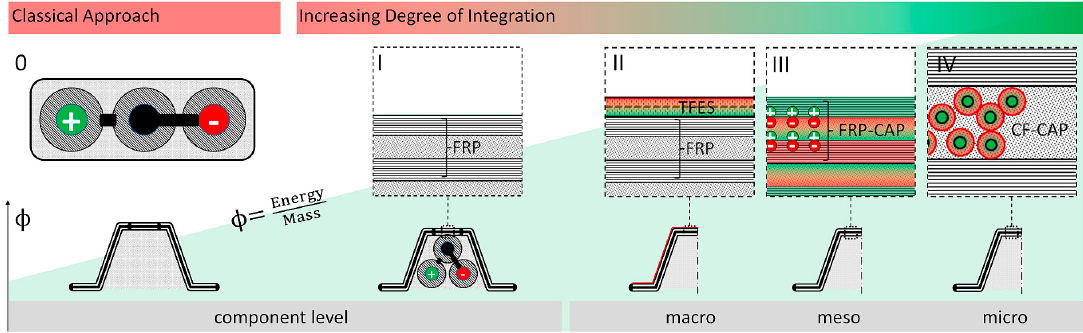
Figure 2. Concept and scales of multifunctional structural energy storage demonstrated for an aircraft fuselage omega stringer: classical functional separation (0), integration of non-load-carrying conventional cells (I), integrated thin-film energy storages (TFES) (II), structural laminate capacitors (FRP-CAP) (III) and microscaled coaxial fiber capacitors (CF-CAP) (IV).